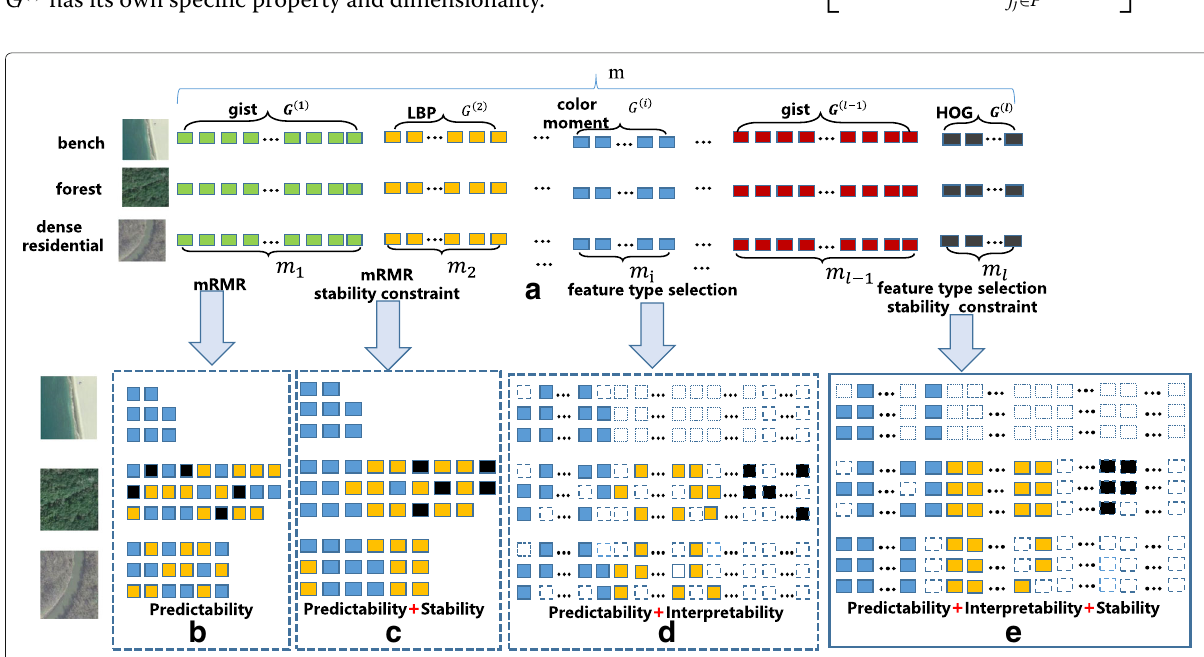
Fig. 1 Feature selection criteria based on predictability, stability, and interpretability. a l different types of feature, corresponding to l different colors. b – d Three criteria with different combinations. e